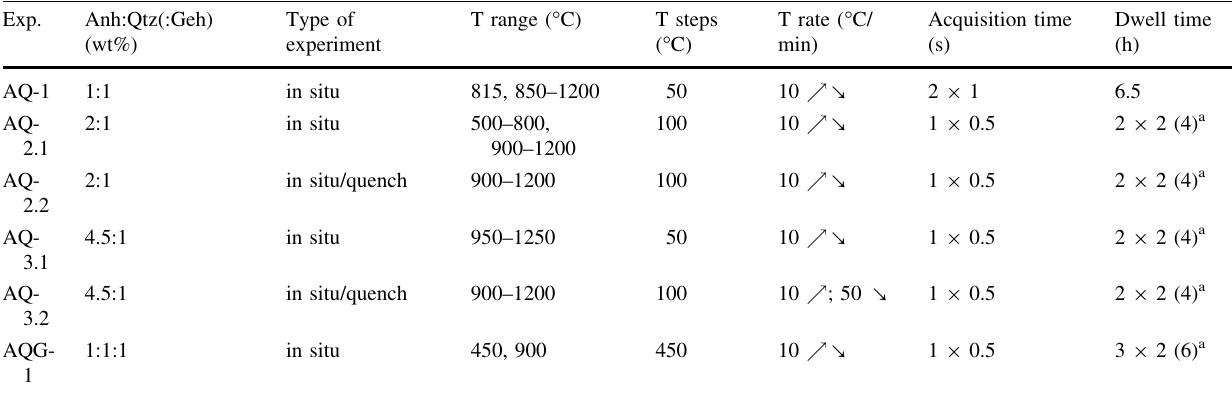
Table 1 Experimental